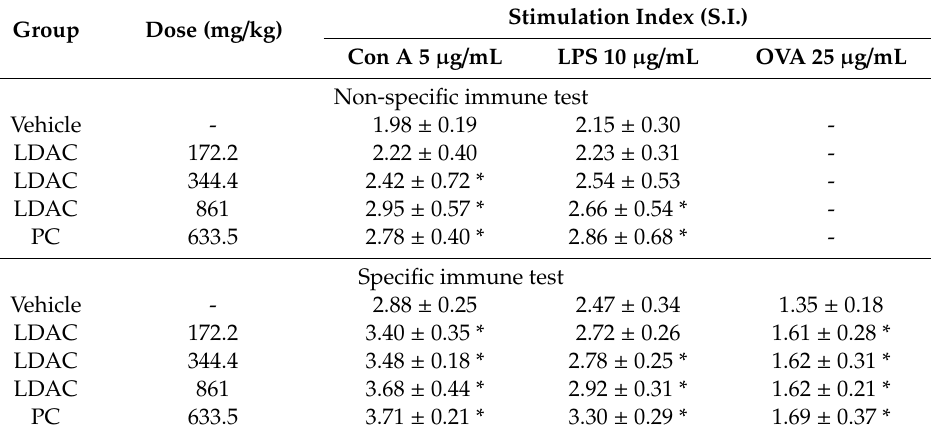
Table 1. Proliferative capacity of spleen immune cells.